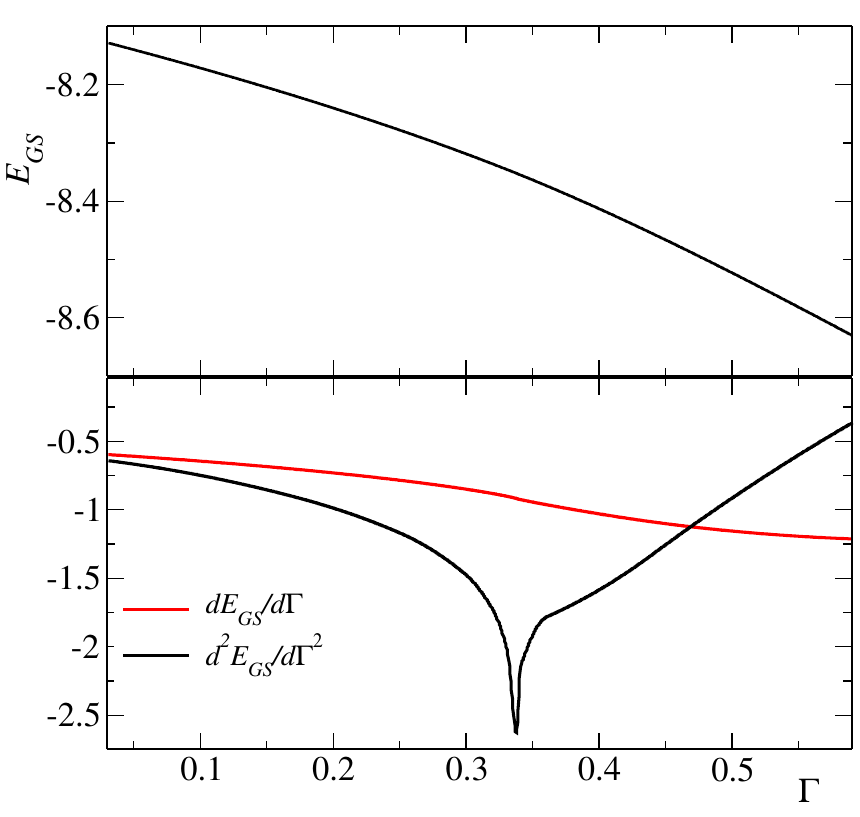
Figure 4: Ground-state energy and its first and second derivatives as a function of Γ = 0.5, and ε = − for U = 3.5, U ′ = 2.5 and J H